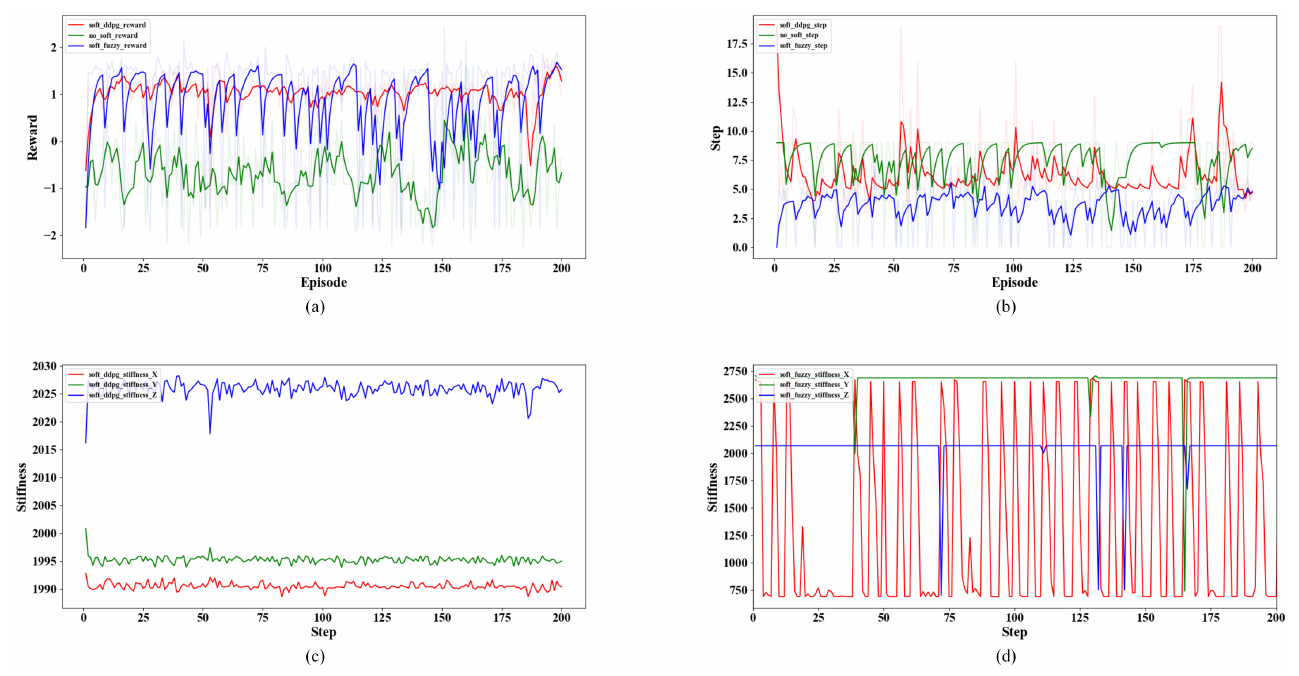
Figure 12. Results of each model performance: ( a ) reward; ( b ) step; ( c , d ): stiffness.